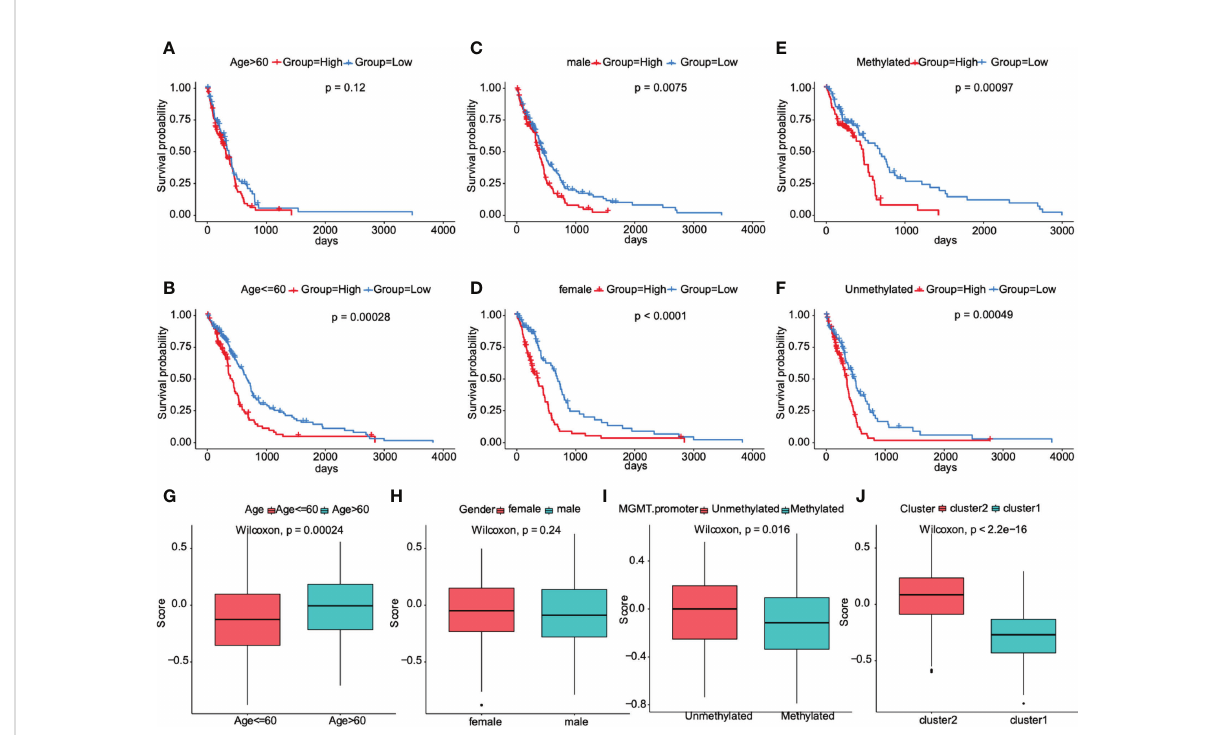
FIGURE 7 Association between the prognostic model and clinical traits for GBM patients. A – F . Subgroup analysis of GBM patients according to age> 60 or ≤ 60, sex, and the status of methylation. The prognostic model we constructed retained its stable prognostic value in multiple subgroups of GBM patients, including patients aged ≤ 60 years (B) , male or female patients (C, D) , and patients with/without methylation (E, F) . G – J . Patients with different clusters (cluster 1 or 2) and clinical features (including age> 60 or ≤ 60, with or without methylation) had different levels of risk scores, calculated according to the prognostic